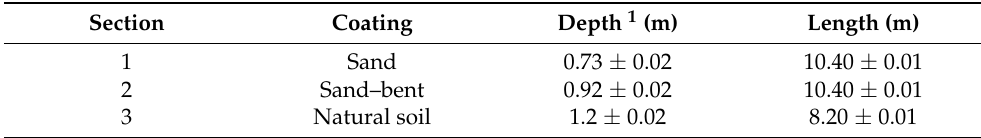
Table 2. Characteristics of the EAHE sections.